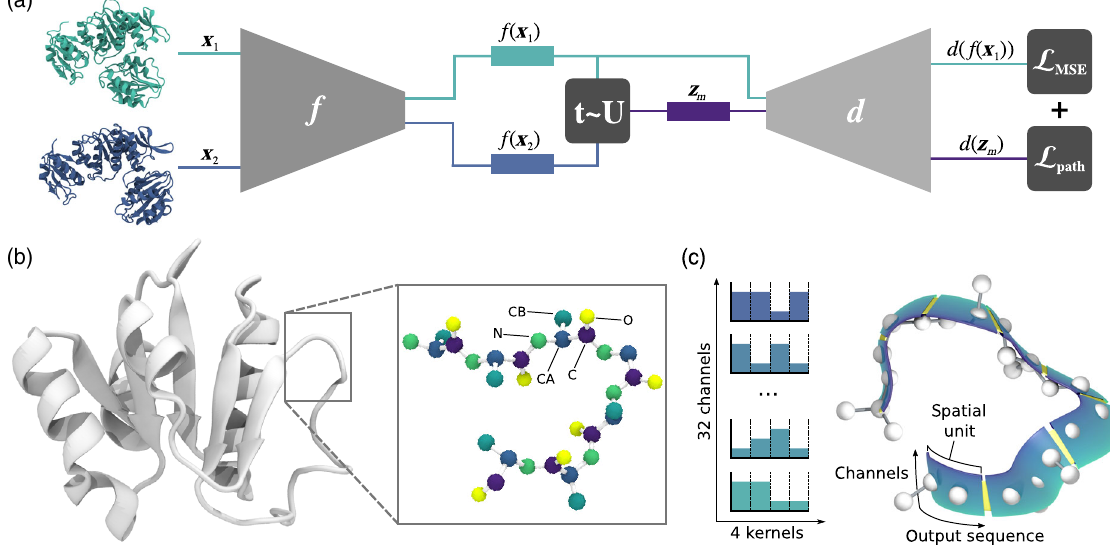
FIG. 1. Neural network design. (a) The generative architecture is composed of an encoder f and a decoder d , and is trained with a collection of protein conformations. The loss function couples a geometric term L to ensure original and encoded-decoded structure MSE are similar, and physics-based terms L to ensure that latent space interpolations z m between any pair of conformations produce path protein structures of low energy. (b) Protein atoms can be sorted in a list so that atoms that are adjacent in the list are also adjacent in the Cartesian space. The convolutional neural network operates on this list, that can be of arbitrary size. (c) The first 1D convolution layer learns 32 × feature detectors, each with a kernel size of 4. The stride is set to 2; therefore the output sequence is half the input size for any input length. Each subsequent layer further reduces the spatial length of the molecule, warping the input such that it becomes progressively deeper and thicker (more ribbonlike) as well as more